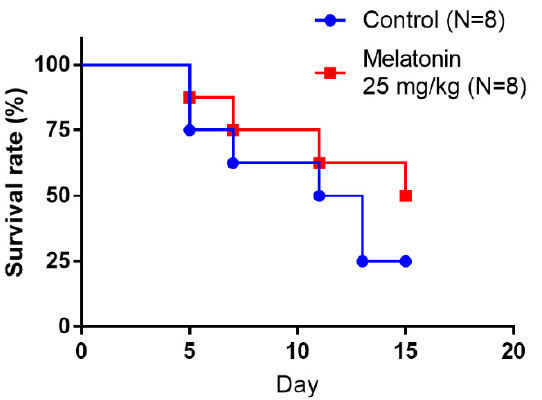
Figure 6. Kaplan–Meier analysis of survival rates of mice according to intravesical instillation of melatonin after UM-UC-3 cells implantation in an orthotopic bladder cancer model. Animals were observed every day for the entire in-life observation period of 20 days. Control ( ● ); Melatonin 25 mg/kg ( ■ ).